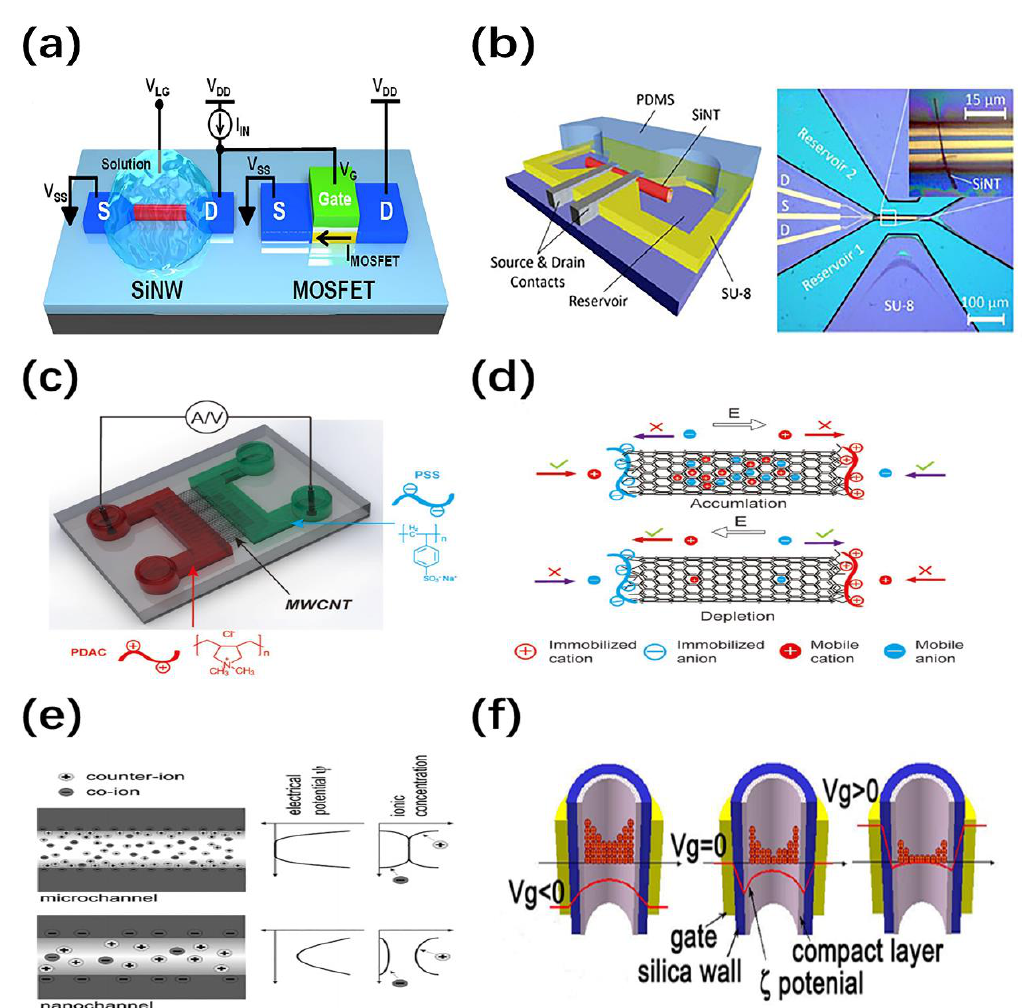
Figure 4. ( a ) Schematic illustration of a SiNW-based ion-sensitive field-effect transistor (ISFET) and a metal-oxide-semiconductor field-effect transistor (MOSFET) [57]; ( b ) schematic illustration of the SiNT-based ISFET device [61]; Schematic illustration of ( c ) the device structure and ( d ) working principle of a multi-walled carbon nanotubes (MWCNT) ionic diode filled with polyelectrolyte solutions (poly(diallyldimethylammonium chloride) (PSS) and poly(sodium 4-styrene-sulfonate) (PDAC)) [11]; ( e ) Schematic illustration of the ion environments and electric potential in microchannel and nanochannel [66]; ( f ) Schematic diagram of field-effect modulation of ion conductance in NT-based FETs [67].